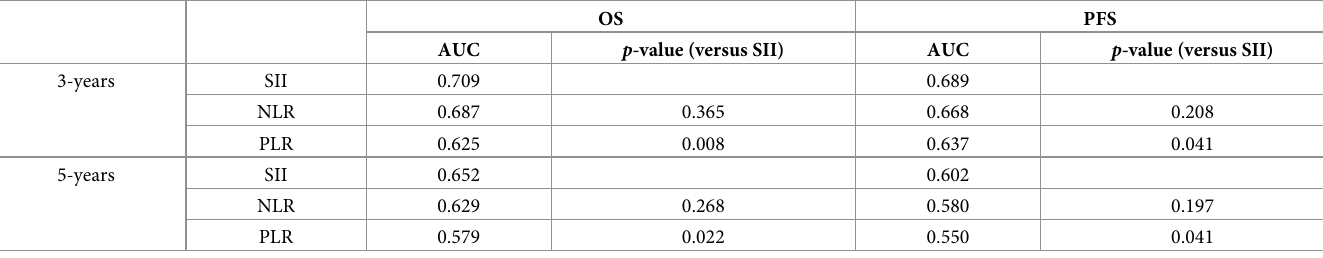
Table 4. Correlations between SII and other systemic inflammatory